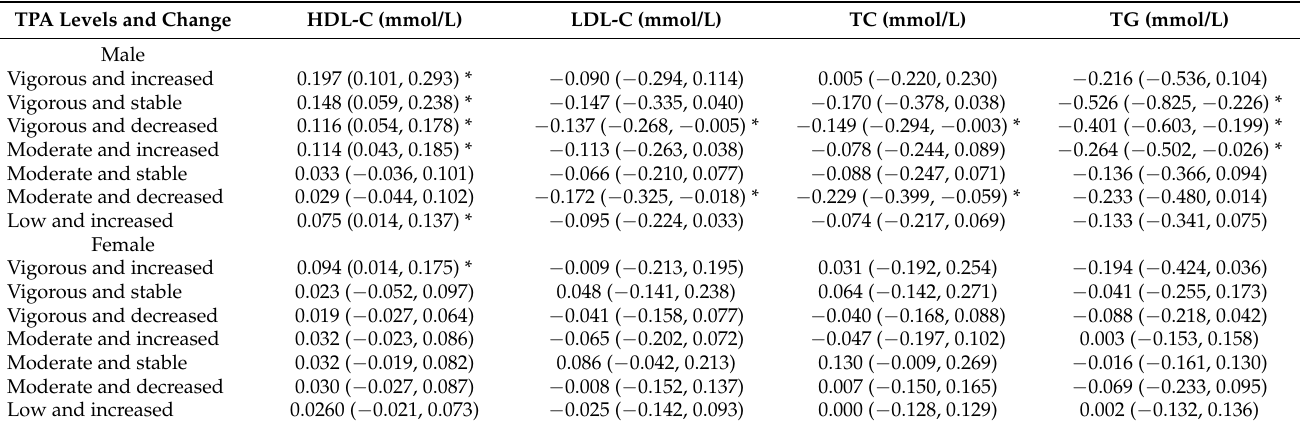
Table 4. Regression coefficients (95% CI) for serum lipids on total physical activity at baseline coupled with the change within six years among Chinese adults from nine provinces, CHNS